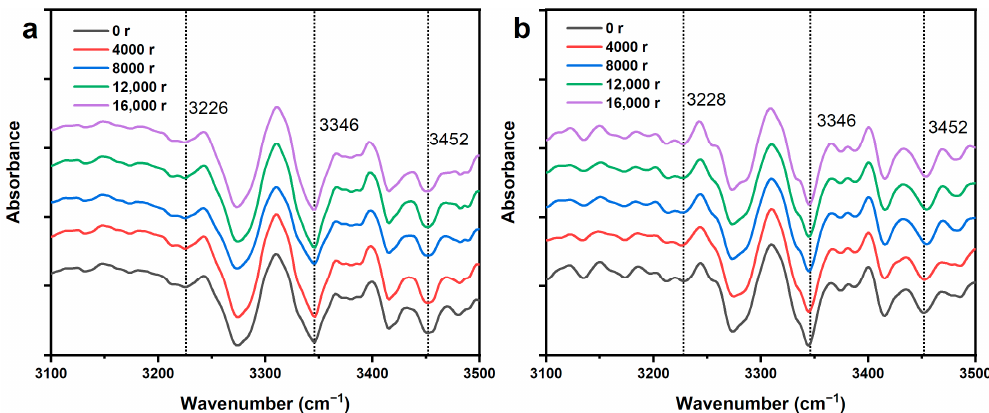
Figure 6. The second derivative of the Fourier transformation infrared spectroscopy (FT-IR) spectra for the refined and unrefined samples: ( a ) softwood fiber and ( b ) hardwood fiber.